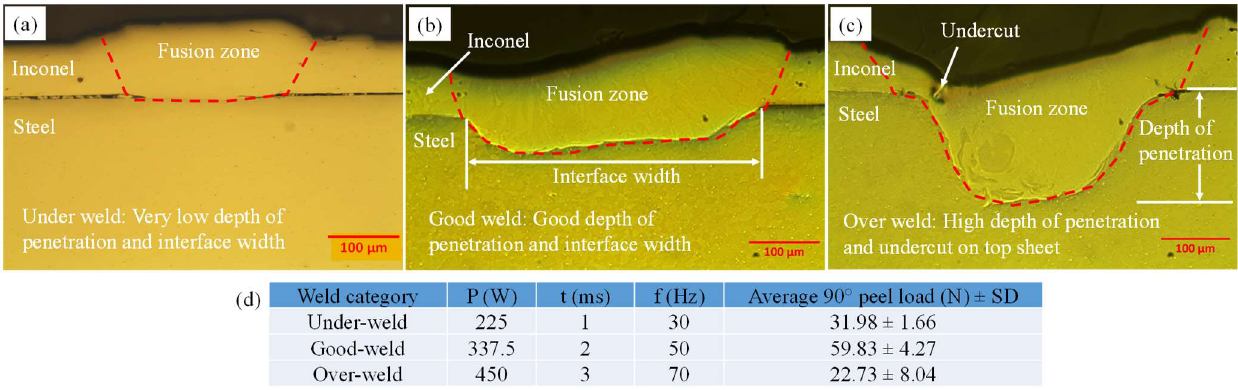
Figure 7. Optical micrographs of laser-welded joints in ( a ) under-weld, ( b ) good-weld and ( c ) over- weld conditions with ( d ) the parameters used for the welding.